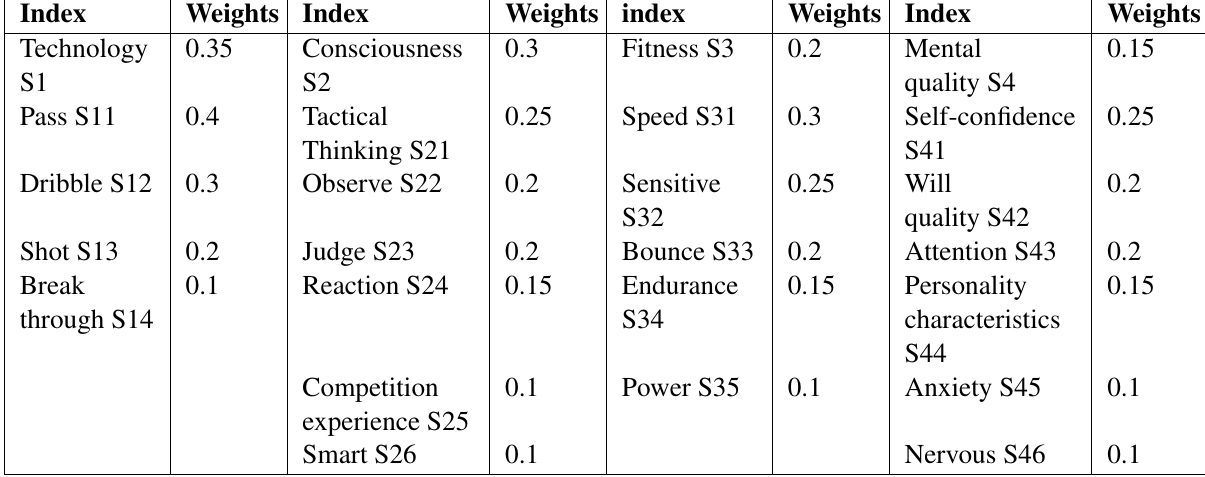
Table 1 Judgement index system and corresponding weight of defender’s offensive ability